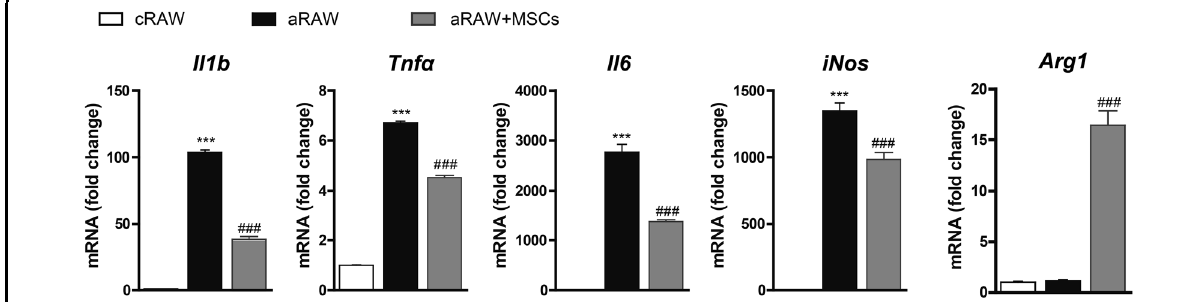
Fig. 3 Coculture of RAW264.7 macrophages with MSCs suppressed LPS-induced M1 macrophage polarization and increased Arg1 expression. MSCs were added to RAW264.7 cells at a ratio of 1:2 (MSCs: RAW264.7 ratio). After 24 h of incubation, LPSs were added to the cells at a fi nal concentration of 10 ng/ml. cRAW, untreated RAW264.7 cells; aRAW, LPS-treated RAW264.7 cells; aRAW + MSCs, LPS-treated RAW264.7 cells cocultured with MSCs. Data are presented as the means ± SEMs ( n = 4). *** P < 0.001 versus control (cRAW); ### P < 0.001 versus LPS-treated RAW264.7 cells